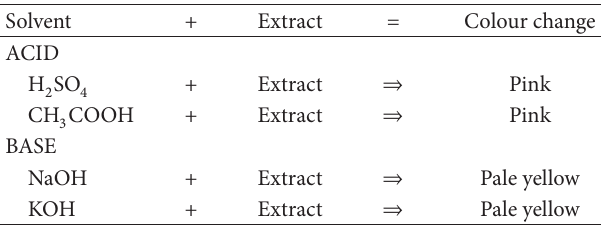
Table 2: Hibiscus extract (cold extract) (initial colour of extract, blood red).